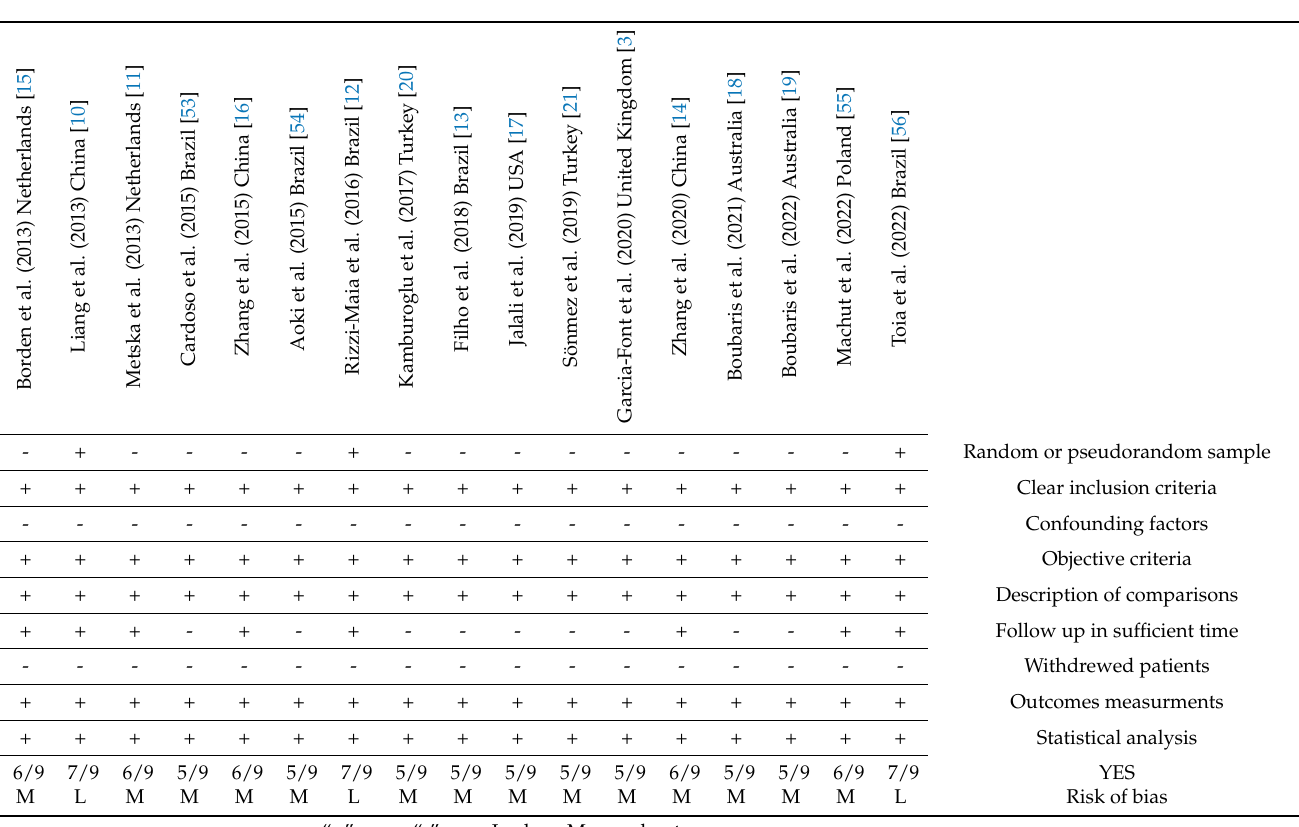
Table 5. Risk of